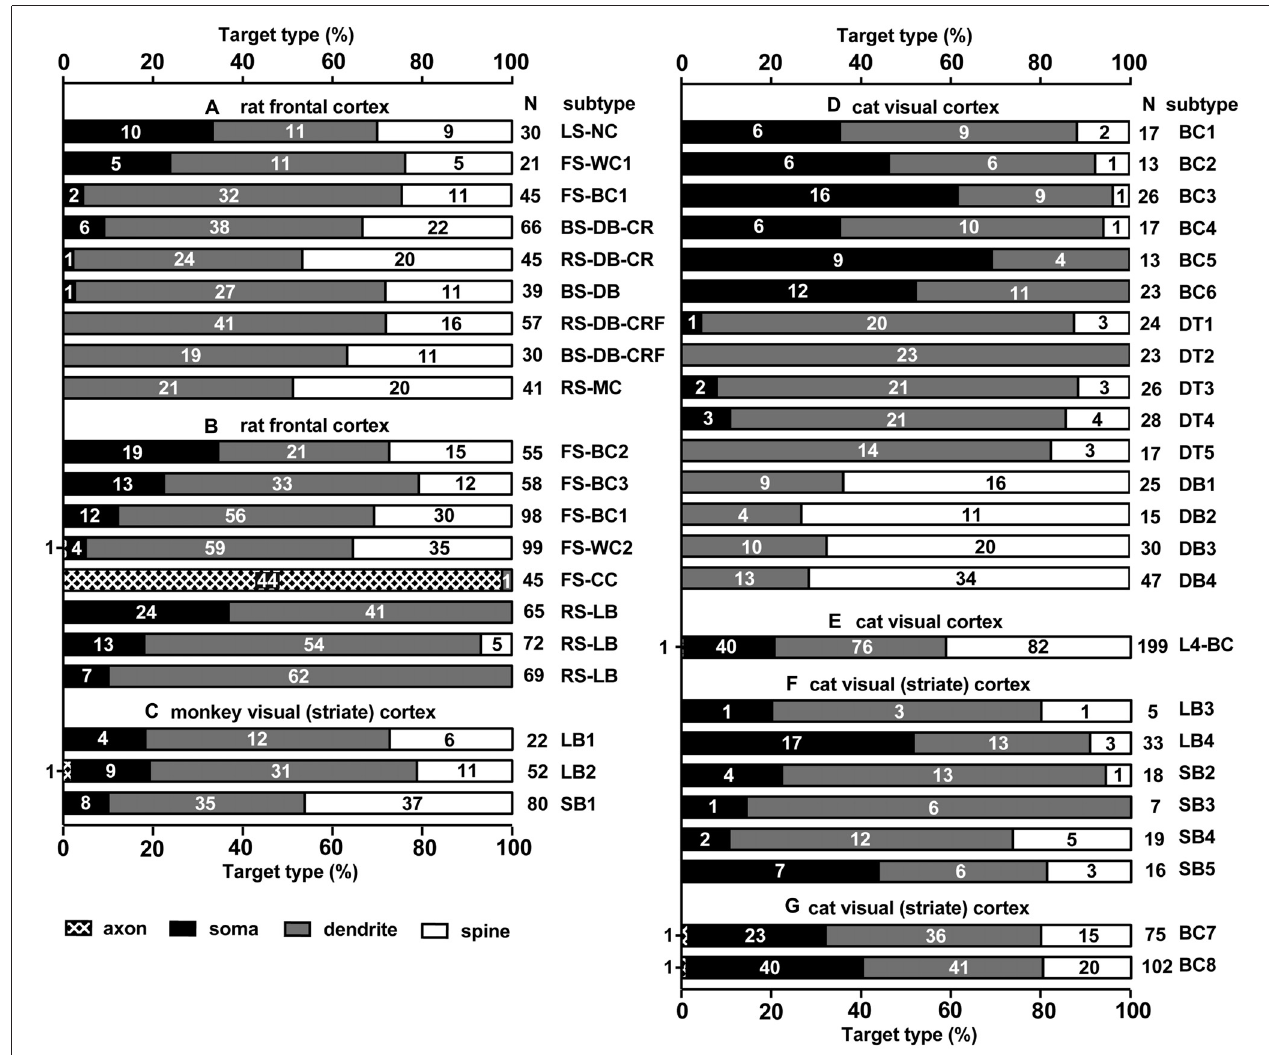
FIGURE 2 | Summary of target structures innervated by different subtypes of cortical inhibitory non-pyramidal cells; in different cortical areas and different species. Each bar corresponds to a single analyzed neuron. Fast spiking (FS)-BC1 cell in (A,B) is the same cell, but analyzed at different occasions and methods. The numbers in the bar chart indicate the number of synaptic boutons analyzed on each type of postsynaptic structure. Total number of analyzed boutons are shown at the right of each bar chart (N). Most spines receiving an inhibitory synapse are dually innervated spines. LS, late spiking; FS, fast spiking; BS, burst spiking; RS, regular spiking; NC, neurogliaform cell; WC, wide arbor cell; BC, basket cell; DB, double bouquet cell; MC, Martinotti cell; CC, chandelier cell; LB, large basket cell; SB, small basket cell (including Clutch cell); DT, dendrite targeting cell; CR, calretinin; CRF, corticotropin releasing factor. (A) Rat frontal cortex is adapted from Kubota et al. (2007), (B) Rat frontal cortex (Kawaguchi and Kubota, 1998), (C) Monkey visual cortex (V1; Kisvárday et al., 1986), (D) Cat V1 (Tamás et al., 1997a), (E) Cat V1 (Kisvárday et al., 1987), (F) Cat V1 (Somogyi and Soltész, 1986), (G) Cat V1 (Somogyi et al.,